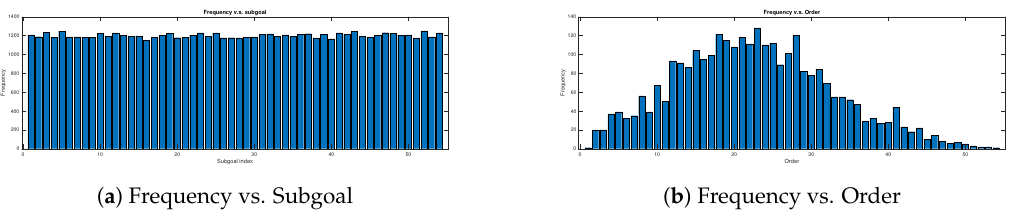
Figure 7. The distribution of 3000 test data. The sugoal is chosen uniformly, and the order is normal.